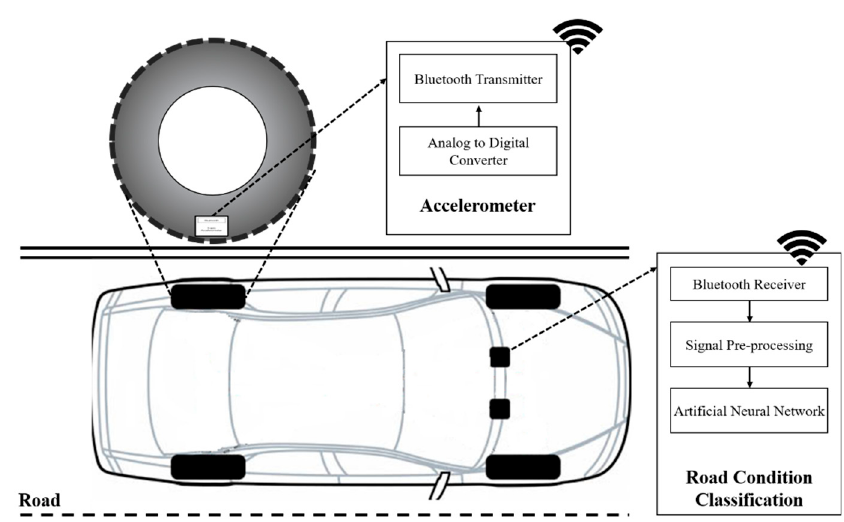
Figure 1. Schematic of the iTire and road condition classification algorithm.